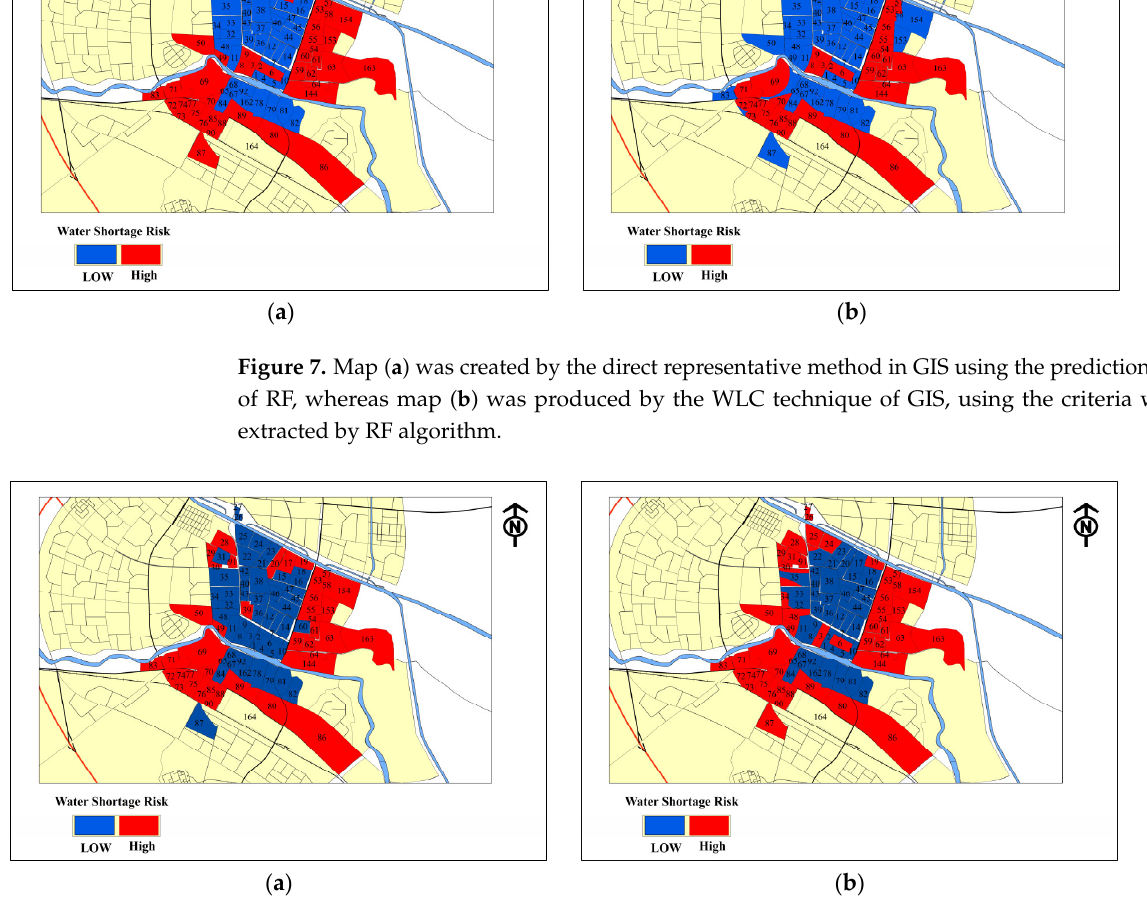
Figure 8. Map ( a ) was created by the direct representative method in GIS using the prediction results of KNN algorithm, whereas map ( b ) was produced by the WLC technique of GIS using the criteria weights gained from KNN algorithm.